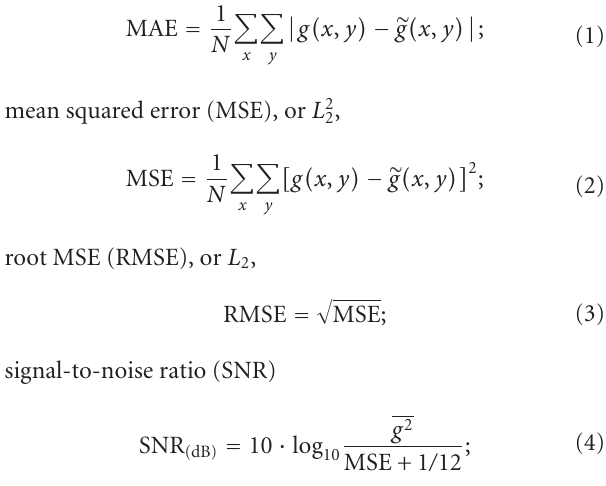
format. Raw data are expressed by means of digital